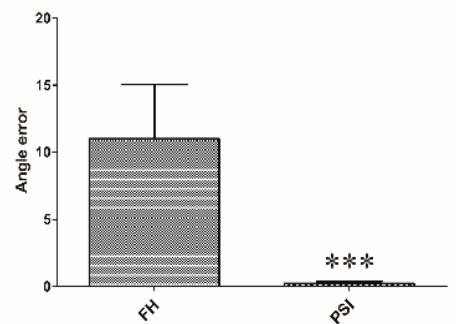
Figure 14. Boxplot displaying the correction angle error of the cutting procedure after applying the two di ff erent methods: freehand (FH) versus patient-specific instrumentation (PSI). *** p < 0.001, t -test vs. FH.